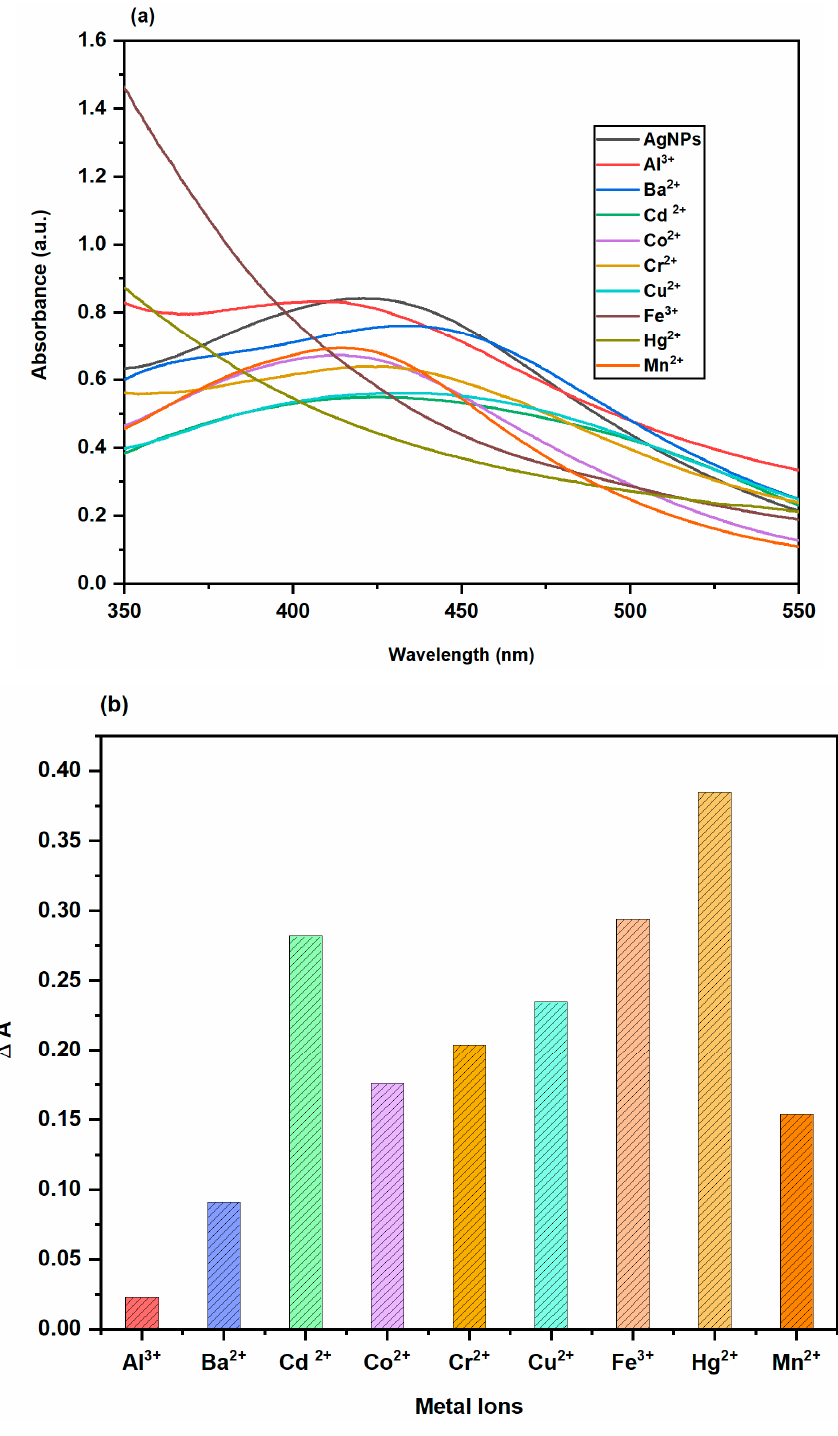
Figure 16. ( a ) UV-Vis spectra of AgNPs solutions in the absence and presence of various metal ions ( b ) The changes in λ SPR values of AgNPs solution containing various metal ions ( ∆ A = A 0 − A). In order to ascertain the sensitivity of the biosynthesized AgNPs colorimetric sensor for Hg 2+ sensing, the variations in the AgNPs solution colour and SPR intensity for various concentrations of Hg 2+ were evaluated. The results were displayed in Figure 17. The colour of AgNPs solution changed progressively from brown to colourless as the concentration of Hg 2+ increased from 10 µ M to 50 µ M, and the SPR intensities of AgNPs solutions